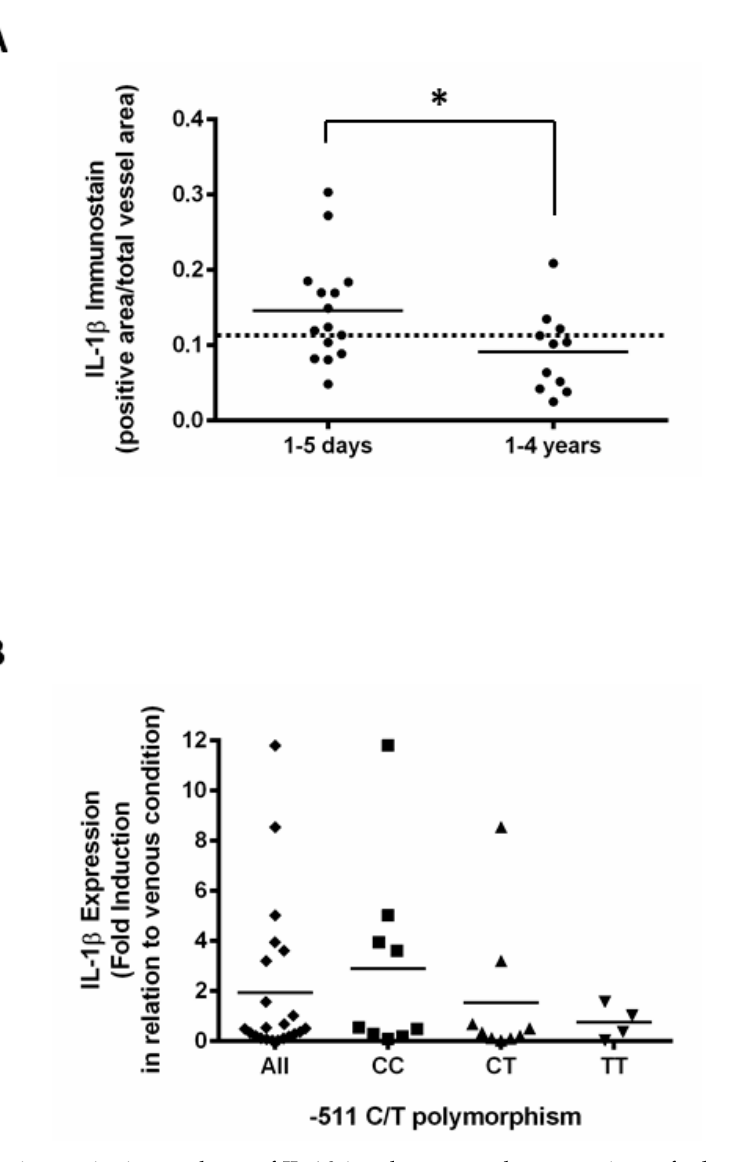
5 of 9 (red) and smooth muscle α -actin (brown) in arterialized jugular vein. Representative sections of normal jugular vein and arterialized jugular vein at 7 days. To further verify whether IL-1 β modulation also occurs in human samples, we performed immunohistochemistry with human saphenous vein grafts obtained from autopsies in which IL-1 β increased in early (1–5 days) vein graft samples compared with late (1–4 years) vein graft samples that were similar to fresh non-arterialized saphenous vein samples (Figure 2A). This finding agrees